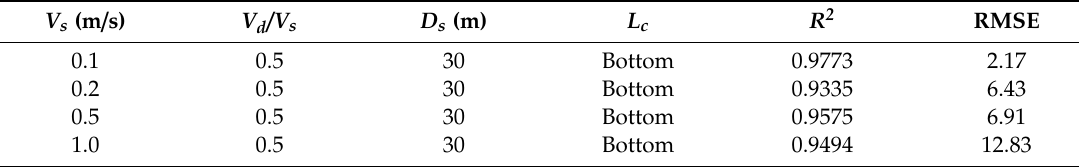
Figure 6. Interface of the spilled styrene predicted using the metamodel (black dots) and computational fluid dynamics (CFD) simulation (blue dots) in the case of t = 1000 s, v d / v s = 0.5, d s = 30 m, and L c = bottom crack. The criterion for the interface was defined as a mass fraction corresponding to the exposure limit (100 ppm). Table 1. The summary of fit with using R 2 and RMSE.